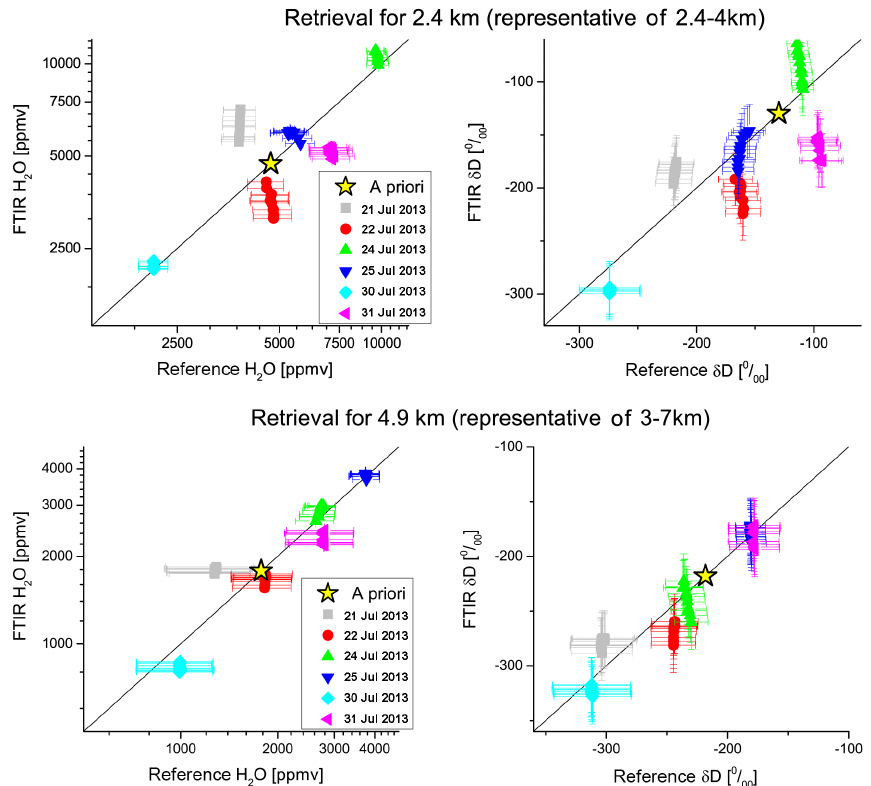
Figure 3. Correlation between the reference profiles (in situ data measured by the ISOWAT instrument for 0–7km and climatology above, then smoothed with FTIR kernels) and FTIR data for FTIR measurements made in the morning (08:15–09:45UT), i.e. before the aircraft flights, but reasonably representative of the free troposphere. Left panels are for H 2 O and right panels are for δ D. Upper panels for retrievals at 2.4km and bottom panels for retrievals at 5km. The black line is the 1 : 1 diagonal. The error bars represent the uncertainty estimations for the reference and FTIR data. Note that for the comparison at 5km a large part of the uncertainty in the reference data is due to the fact that there are no ISOWAT measurements above the aircraft’s ceiling altitude (Schneider et al., 2015, and discussion in Appendix